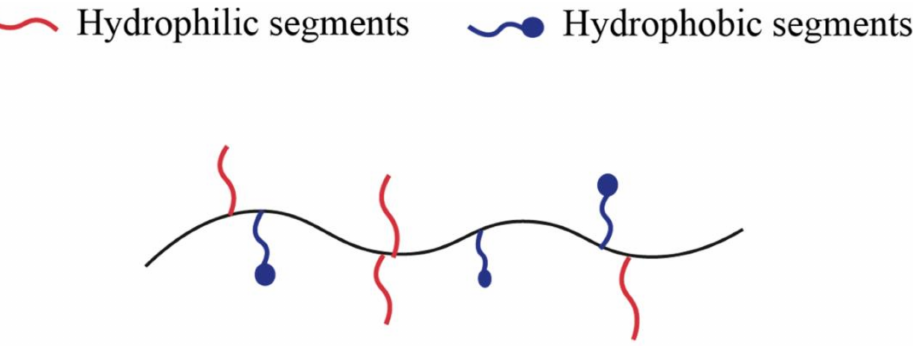
Figure 1. Schematic illustration of amphiphilic